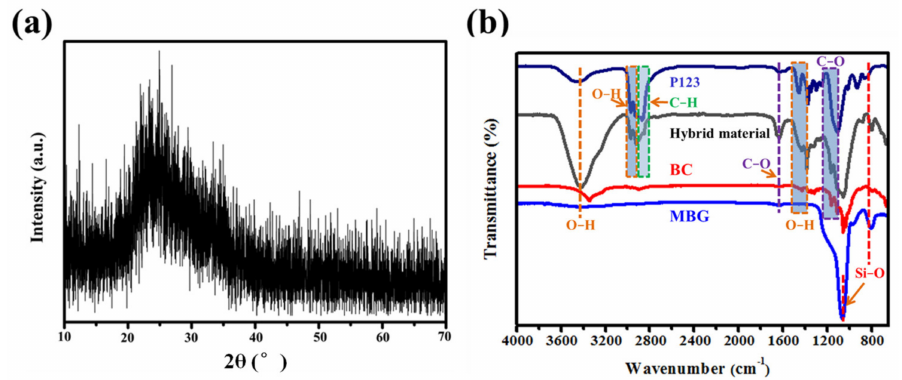
Figure 3. ( a ) XRD patterns and ( b ) FT − IR spectra of P123, BC, hybrid material, and MBG nanofiber